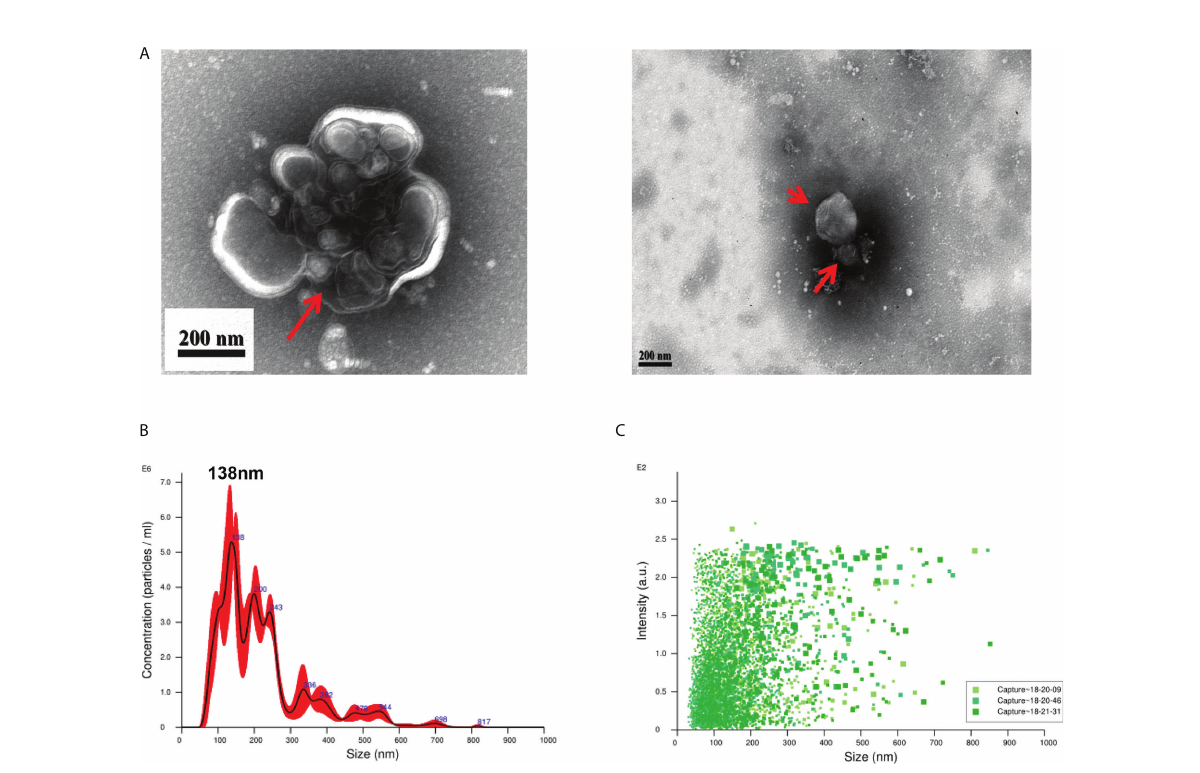
FIGURE 1 Puri fi cation of extracellular vesicles from the culture supernatant of Trichinella spiralis larvae. (A) Extracellular vesicles of T. spiralis (TS-EVs) were analyzed using a negative-staining transmission electron microscope. (B) The size distribution and concentration of TS-EVs was analyzed using NanoSight NS300. (C) The intensity of TS-EVs was analyzed using NanoSight